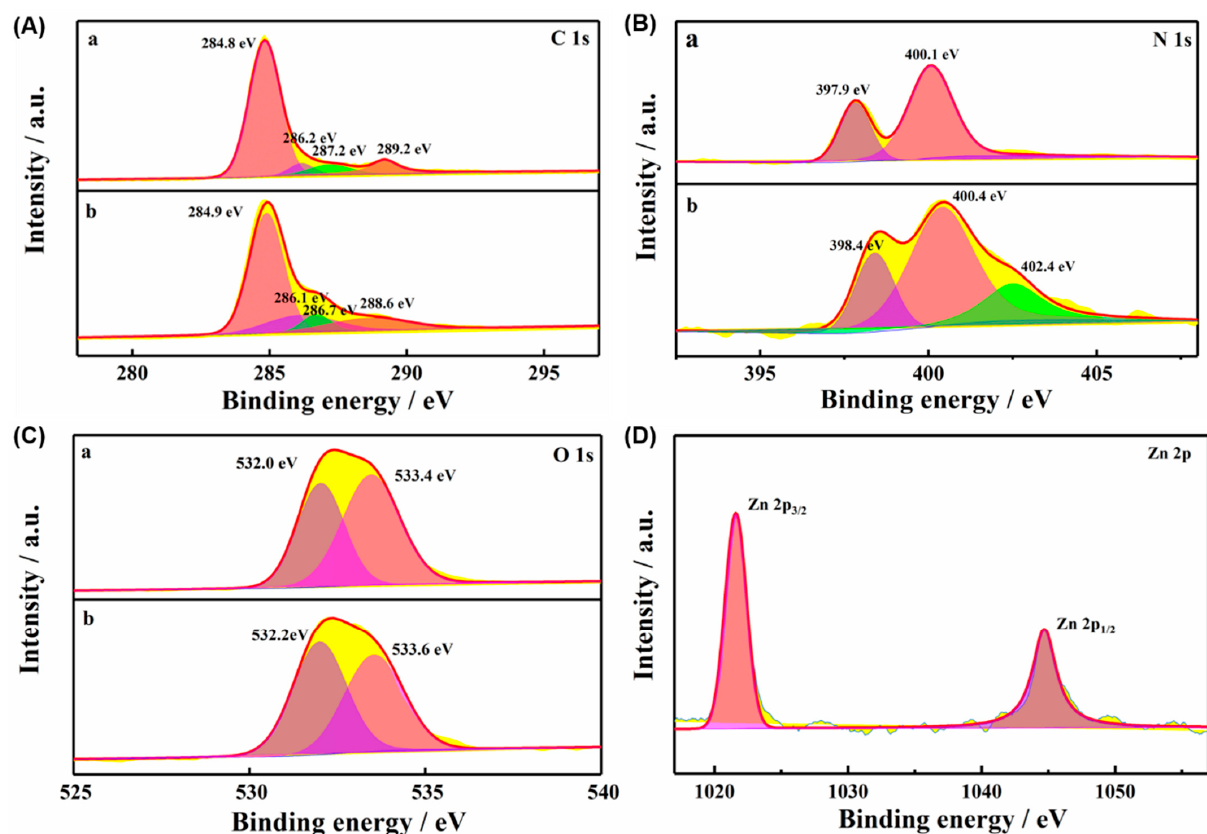
Figure 3. The high-resolution XPS response of ( A ) C 1s, ( B ) N 1s, ( C ) O 1s, and ( D ) Zn 2p of TCPP (a) and TCPP-Zn-(S)-BINOL (b).